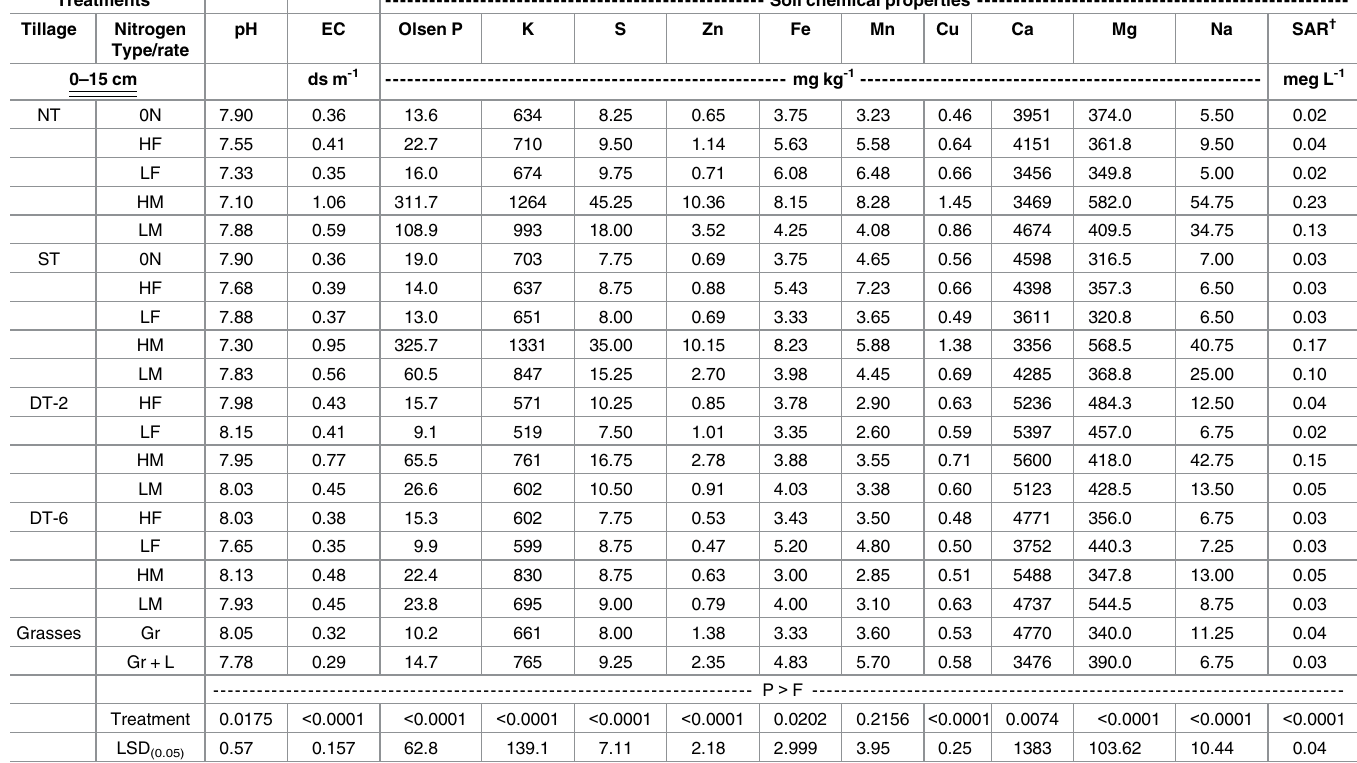
Table 5. Soil chemical properties at 0–15 cm depth from spring of 2012 influenced by different treatments that included tillage treatments: No-till- age (NT); shallow tillage (ST), deep tillage every other year (DT-2); deep tillage once at the initiation of the experiment (DT -6); grass (Gr); and grass + legume (Gr + L) mixtures under different amendments: Chemical fertilizer at high rate (HF) and low rate (LF); beef manure at high rate (HM) and low rate (LM); no nitrogen added, control (0N).